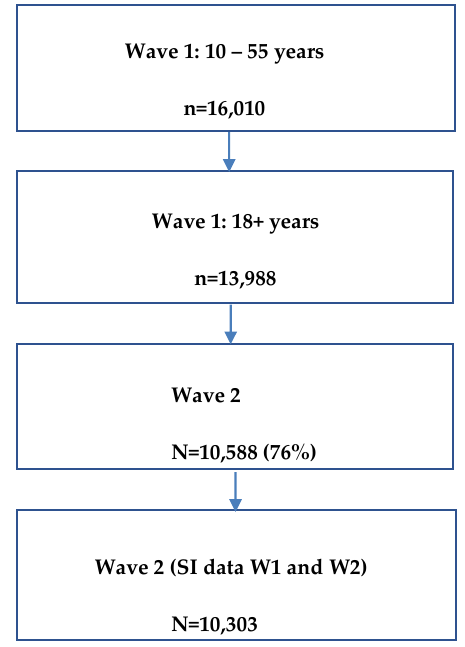
Figure 1. Flowchart of study participants, Wave 1 and Wave 2.